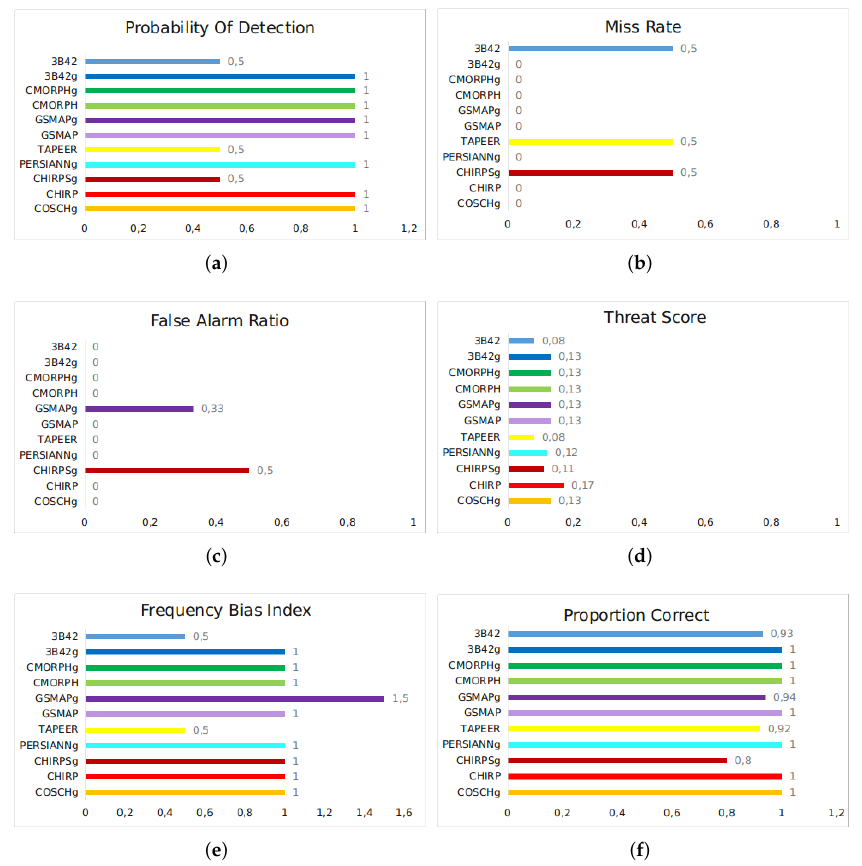
Figure 18. Bar graphs of ( a ) Probability Of Detection (POD); ( b ) Miss Rate (MR); ( c ) False Alarm Ratio (FAR); ( d ) Threat Score (TS); ( e ) Frequency Bias Index (FBI); and ( f ) Proportion Correct (PC) for five days of accumulated precipitation over the northeast coast region of Brazil during 14 April 2016 to 18 April 2016.